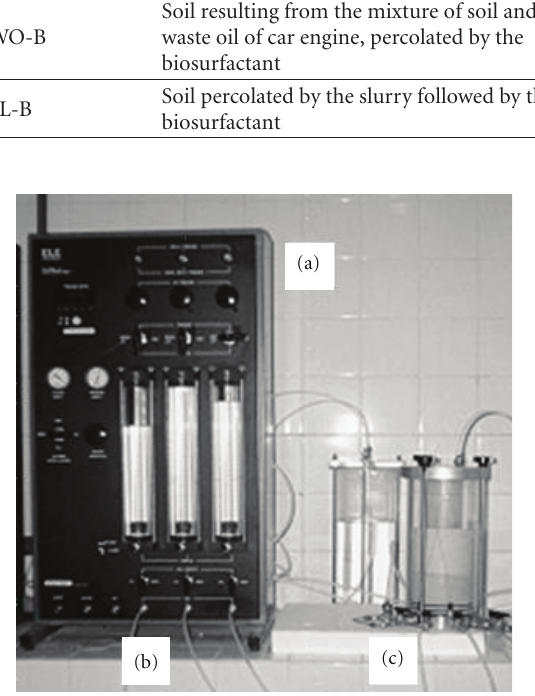
Figure 1: Permeability test system. (a) Pressure control panel. (b) Flow control. (c)